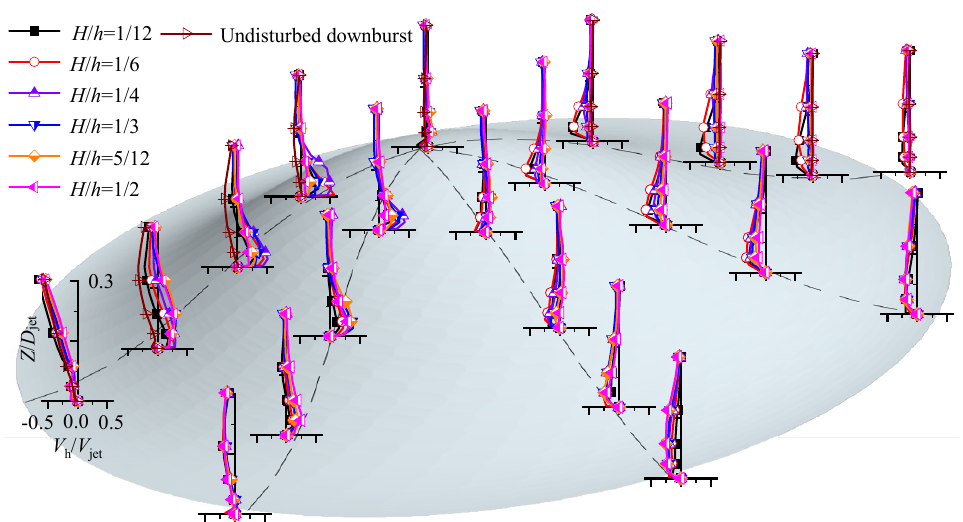
Figure 19. Profiles of vertical wind velocity ( L = 0.5 D jet , r h = 1.0 D jet ).